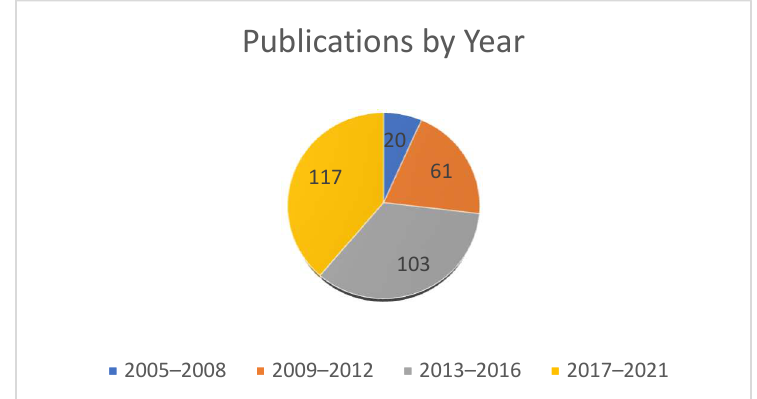
Figure 2. Papers and scientific databases .